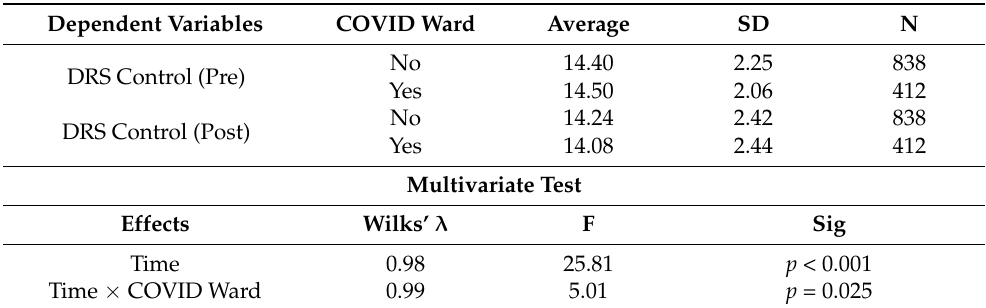
Table 7. Repeated measures ANOVA model of time (i.e., pre- and post-pandemic first-wave effect) and ward effects on DRS control. The model assesses the impact of the first wave of COVID-19 on the control subscale for nurses directly involved in caring for COVID-19 patients and on those who did not. Dependent Variables